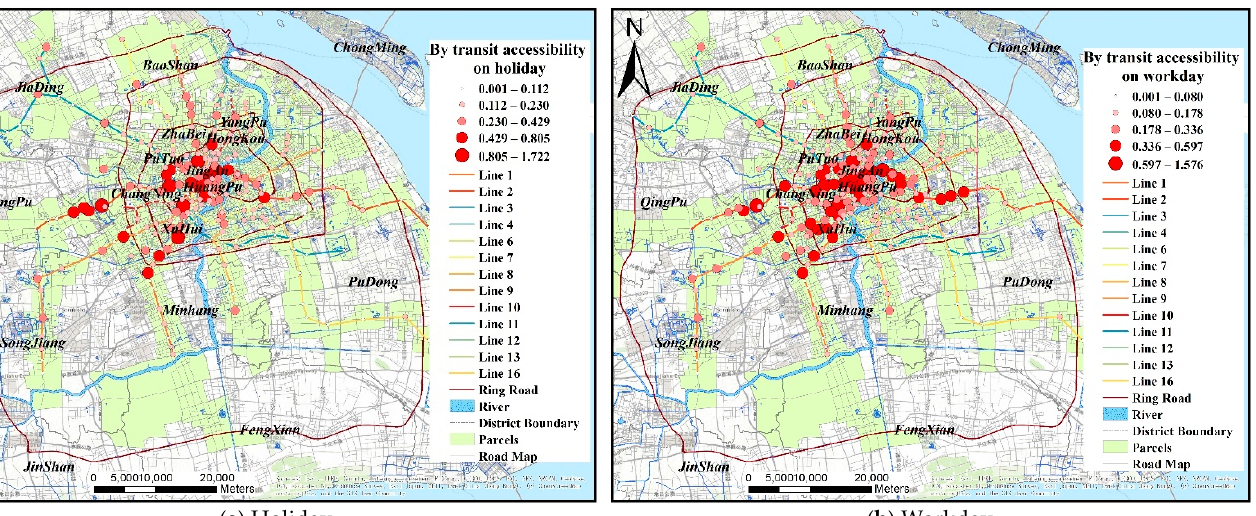
( b ) Workday Figure 6. Distribution of metrorail accessibility by the station.